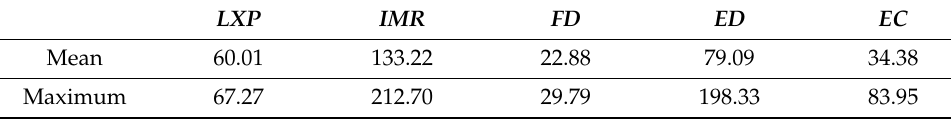
Table 2. Descriptive